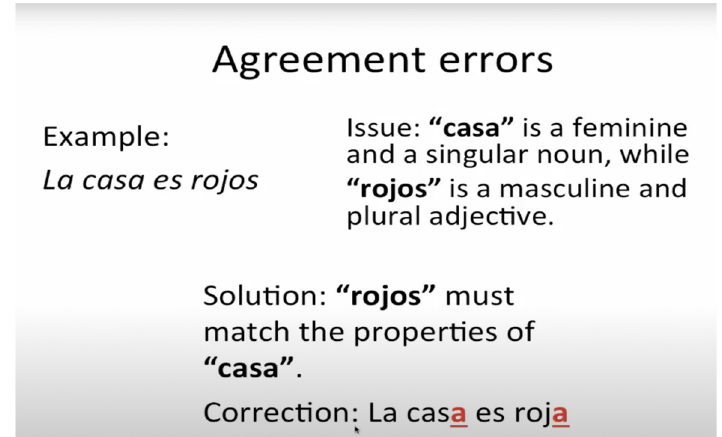
Figure 1. An example of the YouTube tutorial.